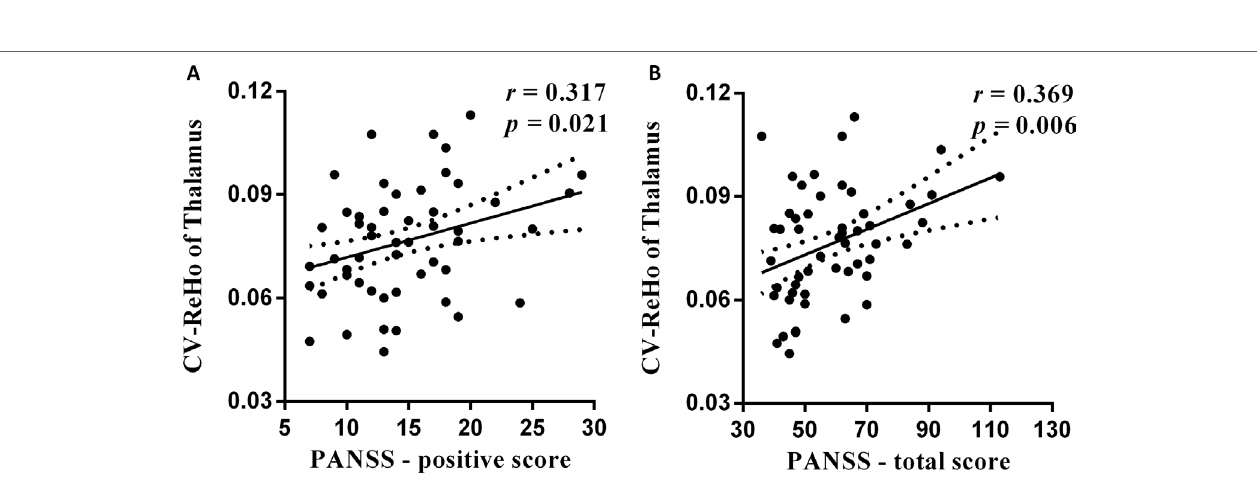
FIGURE 3 | The relationship between altered temporal variability of dynamic ReHo and PANSS scores. (A) The positive association is observed between increased CV score of thalamus region and PANSS-positive score in schizophrenic subjects. (B) The PANSS-total score was also positively related with CV score of thalamus region in